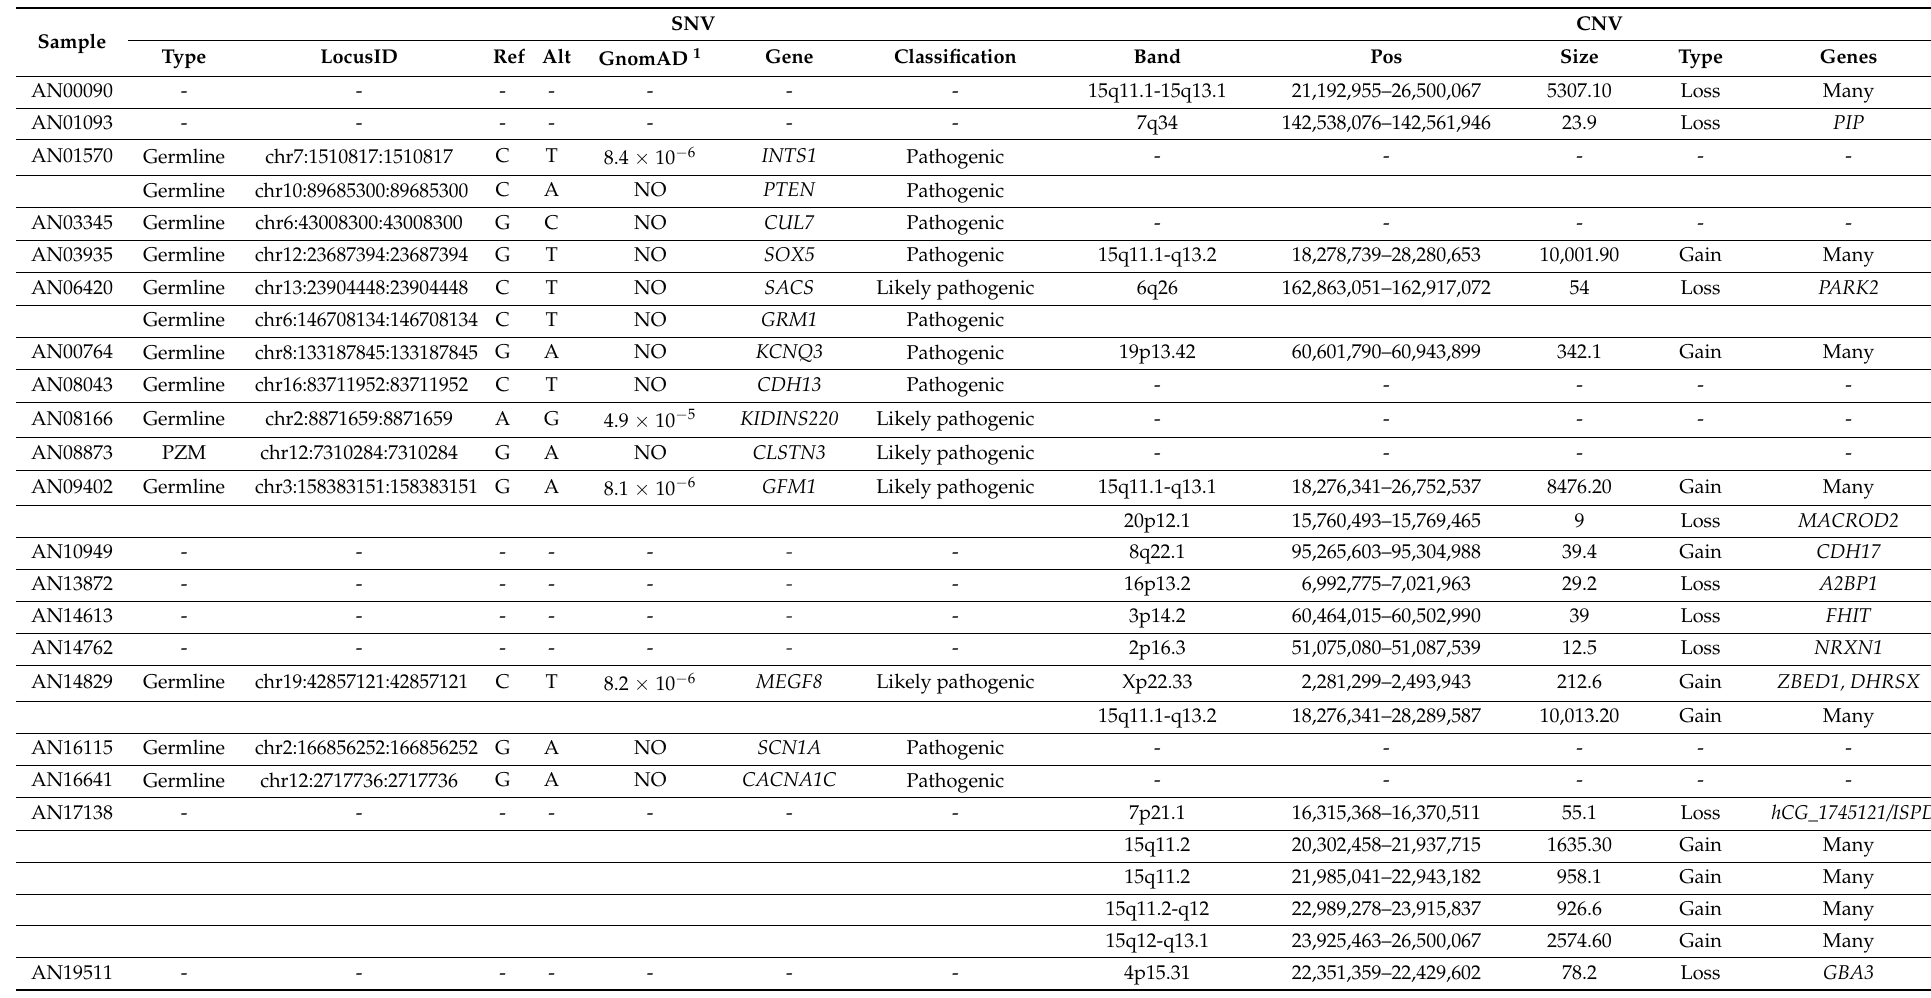
Table 1. Characteristics of rare, predicted damaging mutations clinically classified as pathogenic or likely pathogenic, identified in brain